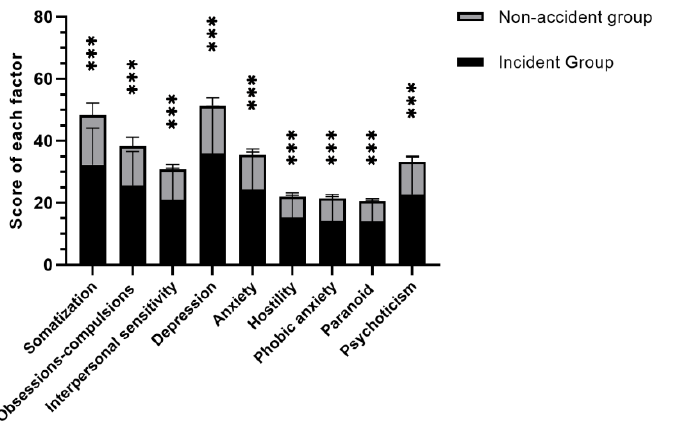
Figure 3. Comparison of the scores of each factor of the SCL-90 scale between drivers in the accident group and non-accident group. Note: *** p < 0.001.